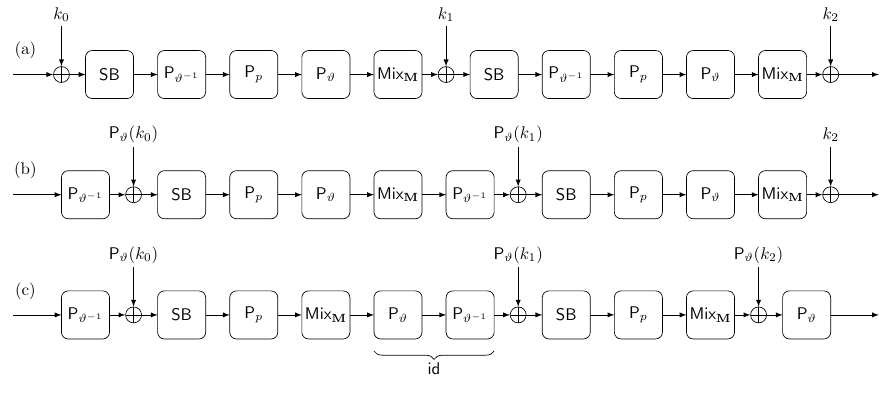
Figure 2: This illustration shows how equivalent permutations lead to the same cipher upto permutation of the input, the output and the round keys. One can easily see that cipher (a) is the same as cipher (b) by using the fact that the S-box layer commutes with the cell-permutation layer. The ciphers (b) and (c) are the same since Permute ϑ (here denoted as P ϑ for short) commutes with Mix M